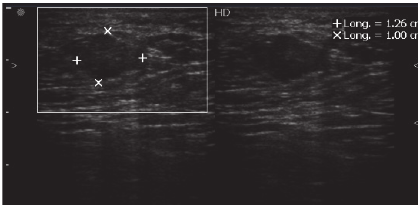
Figure 2: Hypoechoic nodule with indistinct microlobular margins and without vascularity in US study.